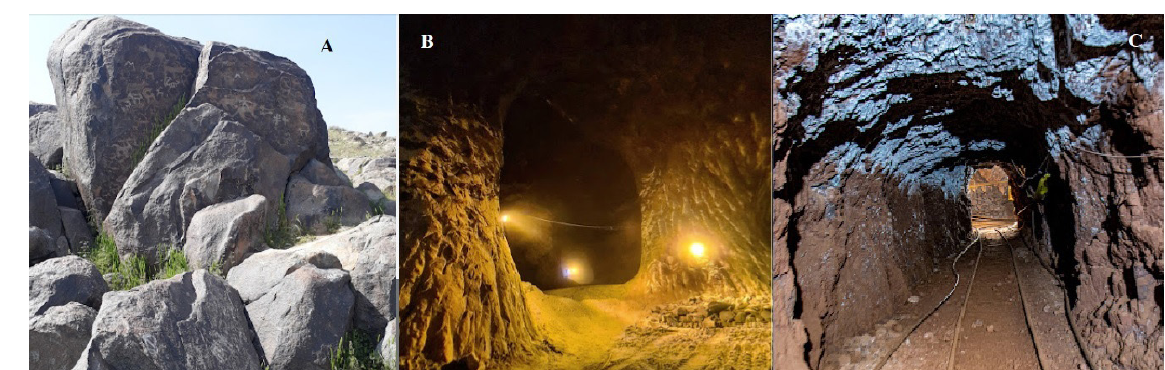
Figure 2. The primary geosites with cultural geomorphology potentials in Neyshabur and Firuzeh Counties. A) Shotor Sang Rock; B) salt cave in Neyshabur; C) Turquoise Mine. (source: Google